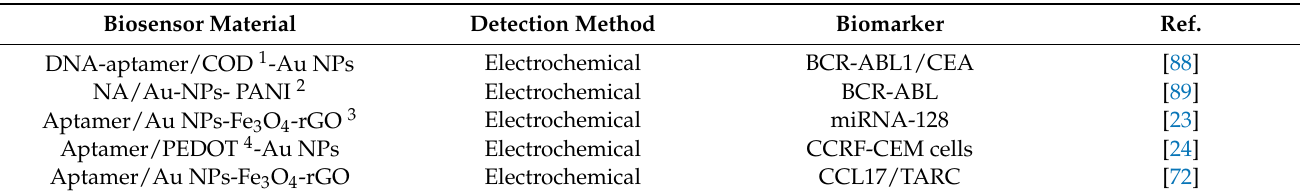
Table 1. Summary of developed biosensors for childhood